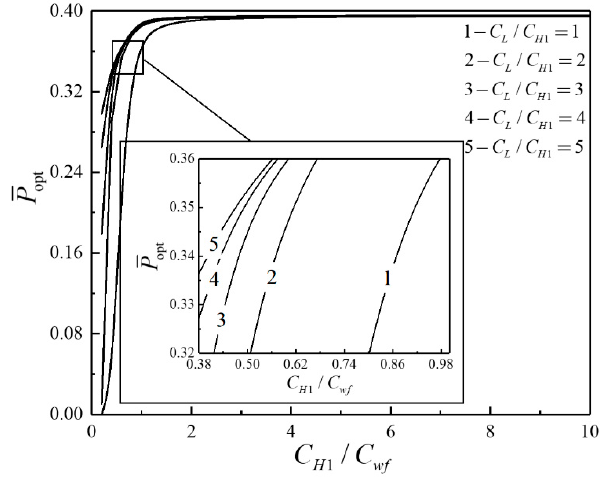
ff erent C L / C H 1 / C C . 1 L H